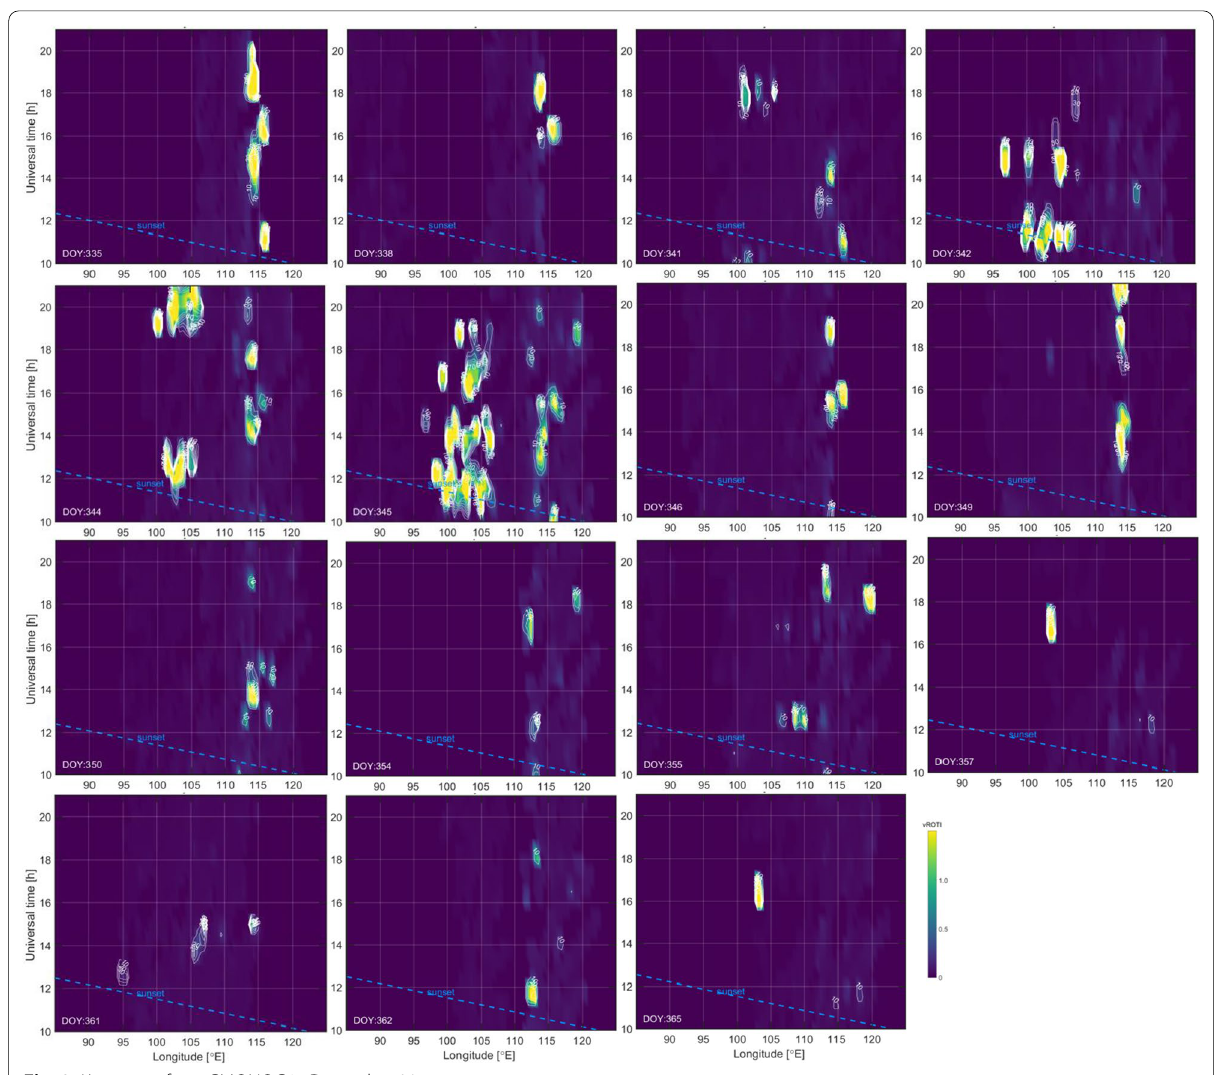
Fig. 8 Keograms from CMONOC in December